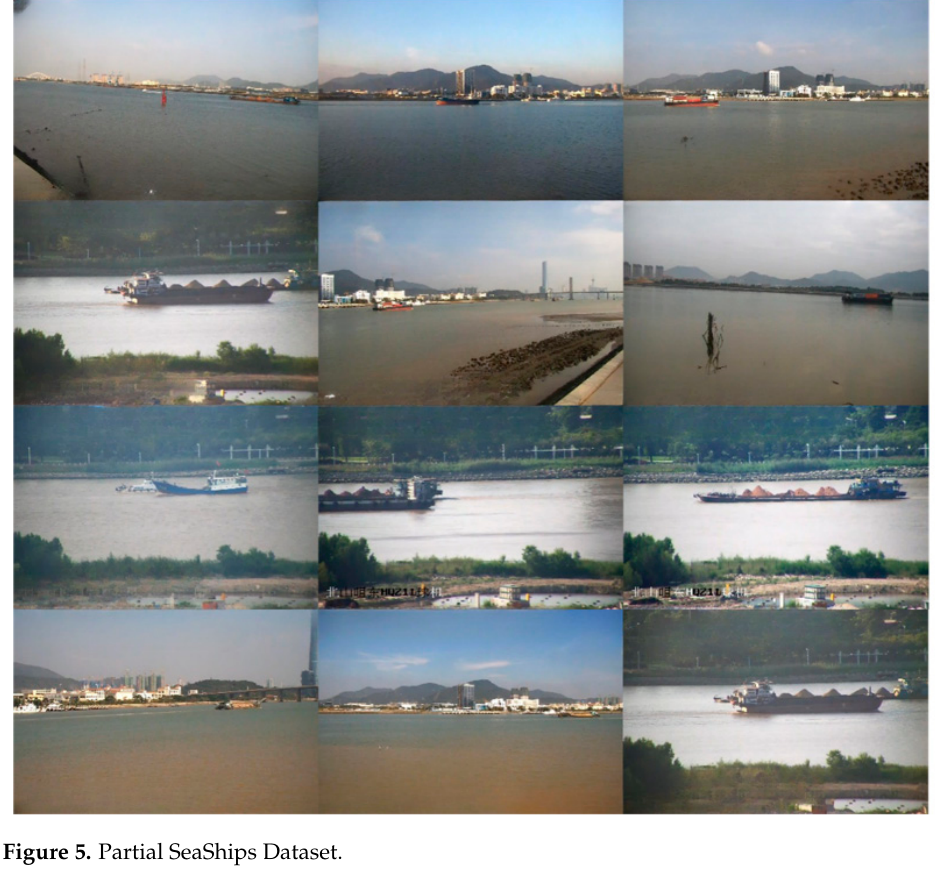
Figure 5. Partial SeaShips Dataset.